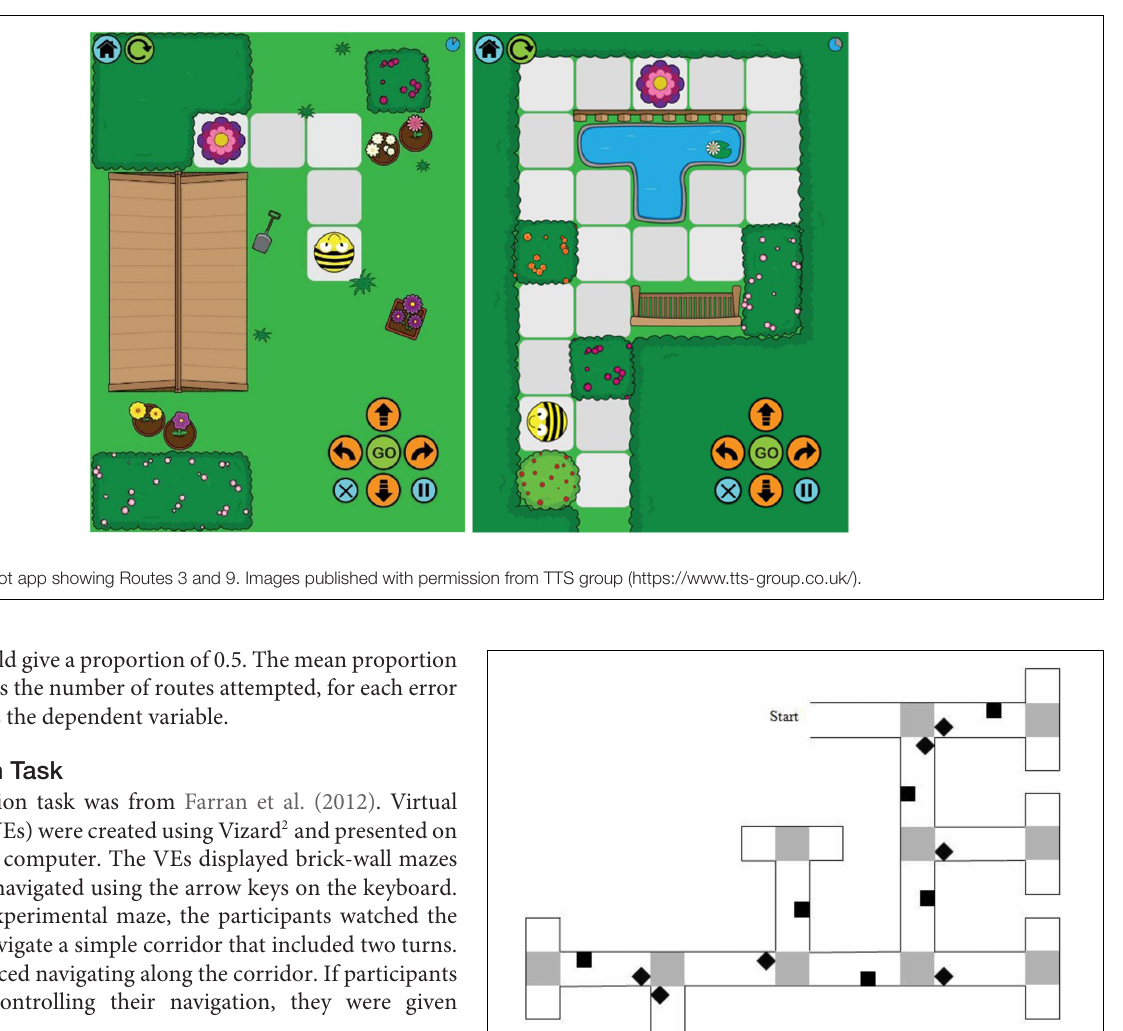
FIGURE 3 | Map of the 6-turn maze layout. Gray squares represent “pebble” texture that was featured at junctions and at the end of cul-de-sacs. Black diamonds indicate junction landmarks. Black squares indicate path landmarks. Reproduced from: Farran et al.